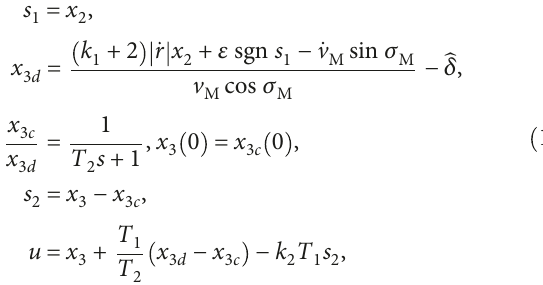
Figure 1: Relative motion between the interceptor and